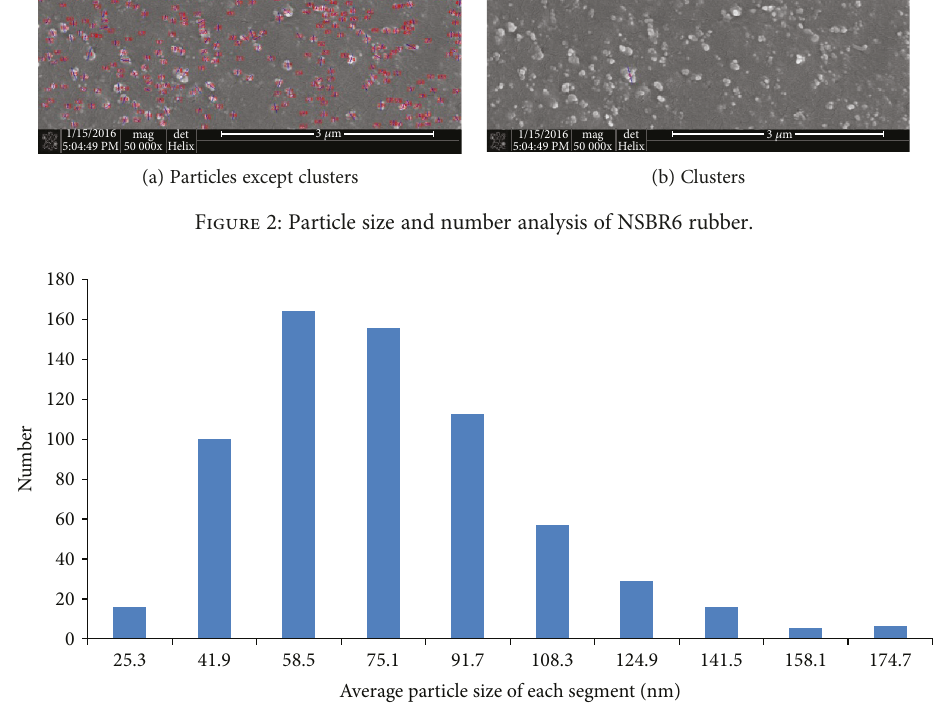
Figure 3: Particle size and diameter statistics of NSBR6